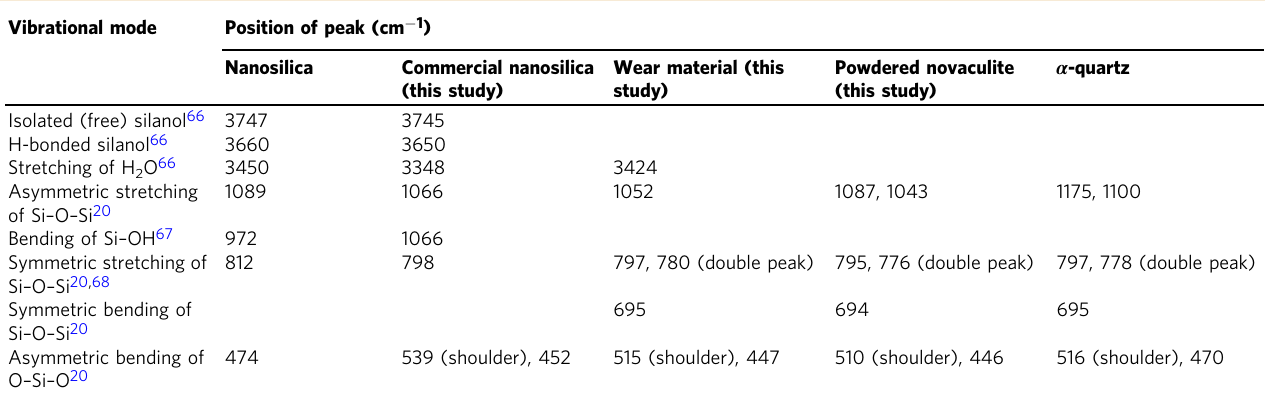
Table 2 Peak positions in the FT-IR spectra and their corresponding vibrational